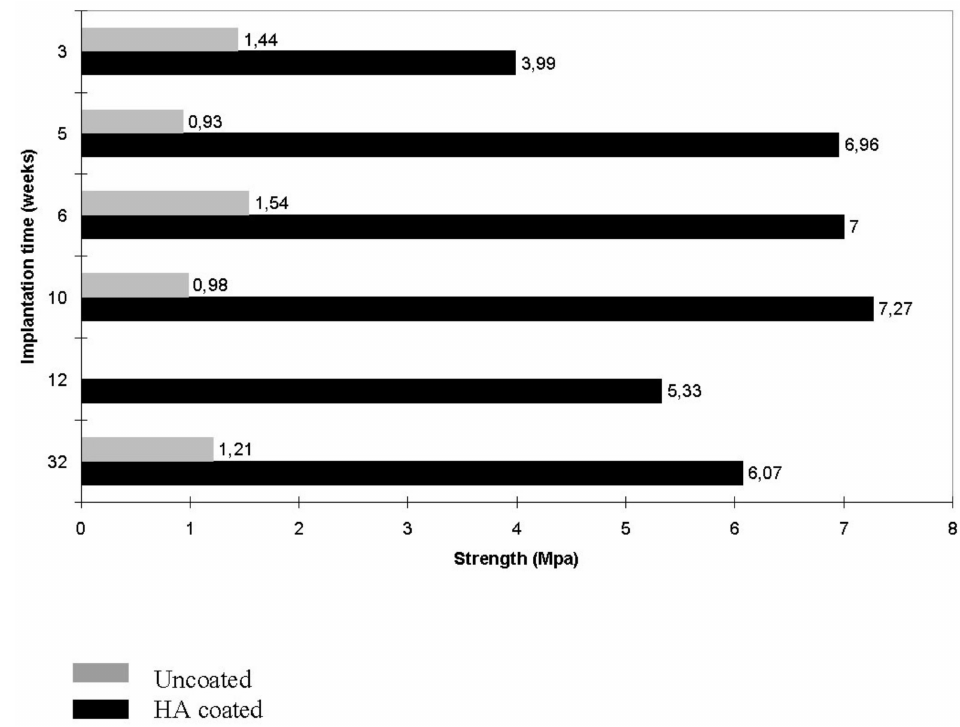
Figure 17. Shows how a plasma-sprayed HA coating on a porous titanium (dark bars), dependent on the implantation time, will improve the interfacial bond strength compared to uncoated porous titanium (light bars). Reprinted from Ref. [50] with